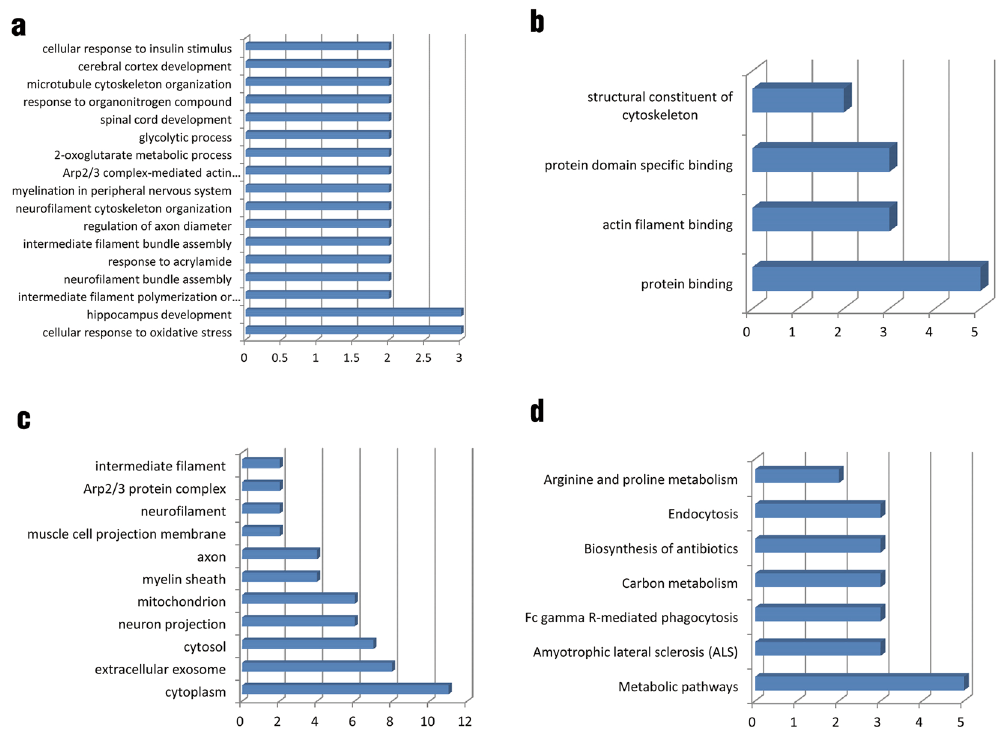
Figure 4. Effects of nimesulide on hippocampus proteomics in CUMS rats. ( a–c ) Functional annotations generated by GO analysis: biological process ( a ), molecular function ( b ) and cellular component ( c ). ( d ) Significant pathways generated based on the KEGG